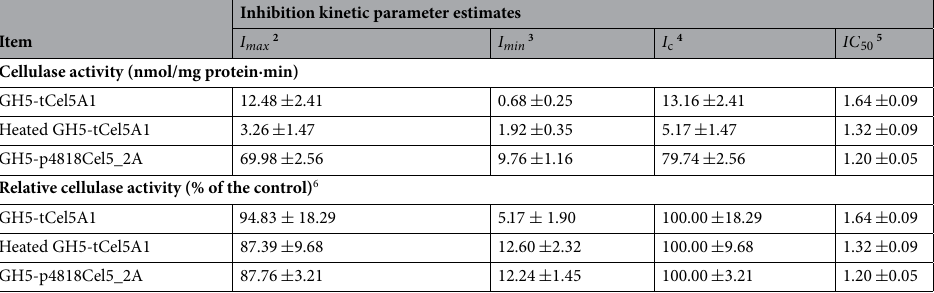
Table 3. Comparative summary of the Experiment-3 in vitro inhibition kinetics 1 of GH5-tCel5A1, the heat- treated GH5-tCel5A1 and GH5-p4818Cel5_2A under the intestinal trypsin (74 U/mL) condition obtained through the Eadie-Hofstee linear regression analyses. 1 Values are parameter estimates or means ± SE (n = 72) obtained through the Eadie-Hofstee regression linear analyses, representing the inhibition kinetic parameter estimates obtained from the three intestinal trypsin (74 U/mL) inhibition experiments with 4 replicates per time point in each experiment, as shown in Figs. 12, 13, 14. 2 I max is the maximal magnitude of inhibition in the cellulase activity (nmol/mg protein·min or % of the control, I c ; means ± SE, n = 12) calculated according to Eq. (2). 3 I min is the minimal residual cellulase activity (nmol/mg protein·min or % of the control, parameter estimate ± SE, n = 72) under the intestinal trypsin (74 U/mL) inhibition condition obtained from Eq. (1). 4 I c is the mean cellulase activity of the control group (nmol/mg protein·min or % of the control I c ; means ± SE, n = 12). 5 IC 50 is the incubation time (h, parameter estimate ± SE, n = 72) required to reach the half maximal inhibition of the cellulase activity. 6 Relative cellulase activity calculated as percentage (%, means ± SE, n = 12) of the control group ( I c ) measured at 0-min exposure to the intestinal trypsin (74 U/mL)